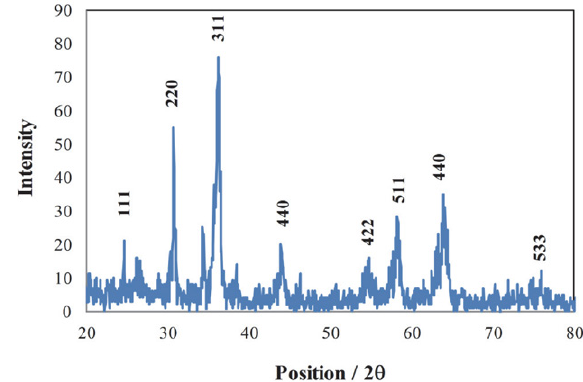
Figure 1. XRD patterns of AlCoFe 2 O 4